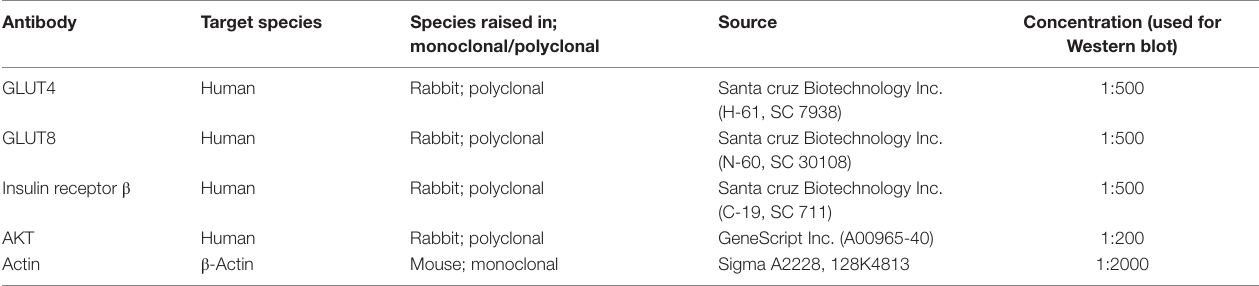
TaBle 1 | Details of antibodies used for Western